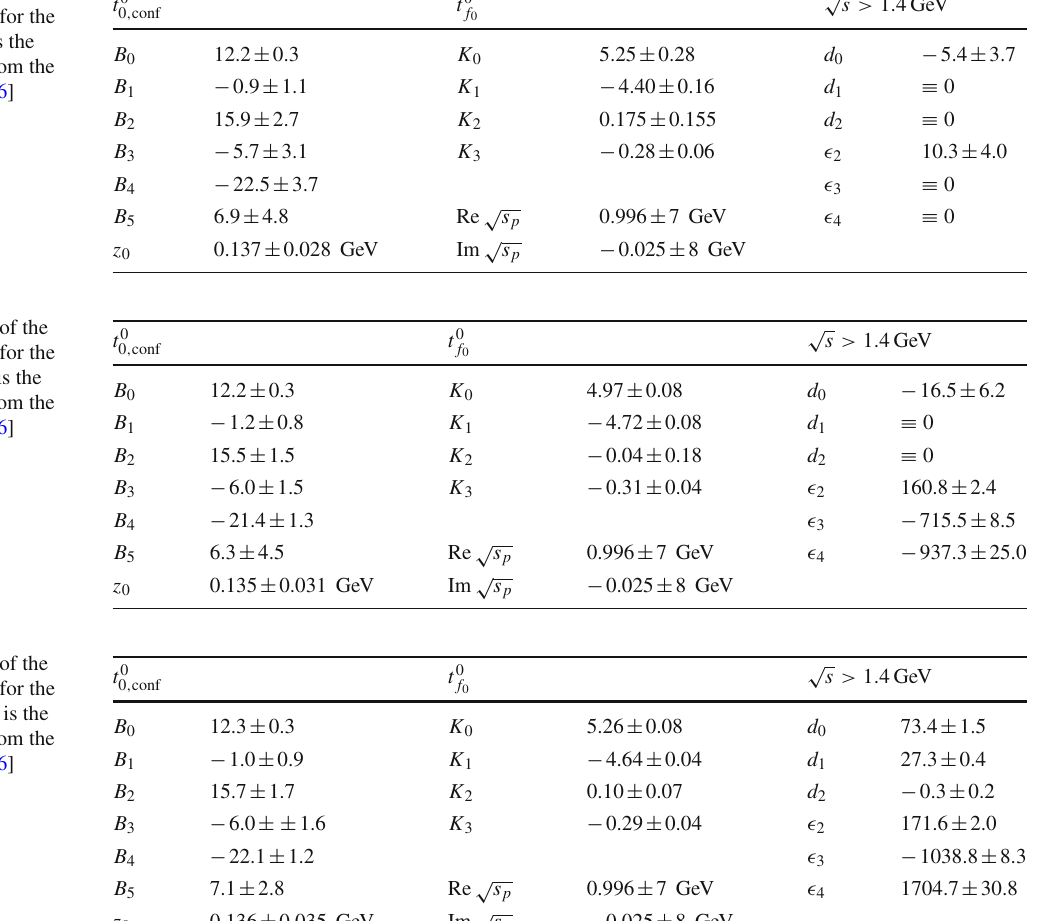
Table 1 Fit parameters of the global parameterization for the S 0-wave solution I. s p is the f 0 ( 980 ) pole position from the dispersive analysis in [36]